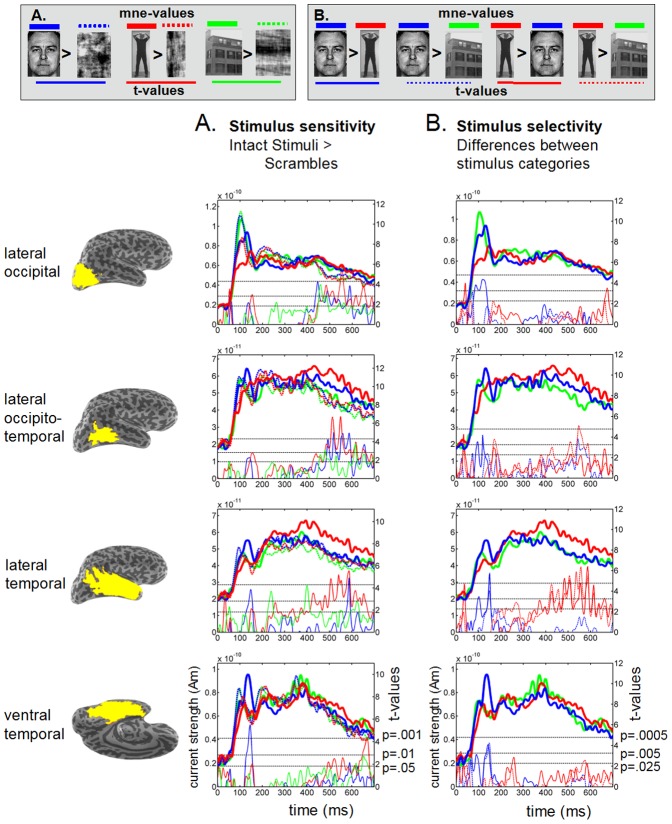
Time courses of MEG source estimates in anatomical regions of interest from the right hemisphere.Grand average (n = 10 subjects) time courses of the mean estimated current strength (thick lines) for intact (solid lines) Faces (blue), Bodies (red) and Houses (green) and their Fourier-scrambled versions (dashed lines), extracted from several large anatomical cortical regions. The thin line curves show the corresponding t-values for planned comparisons. The dotted black horizontal lines indicate the t-thresholds that correspond to α-values of 0.05, 0.01 and 0.001. A. Category sensitivity: The thin lines display the t-values for the contrasts between each intact stimulus category and its own scrambled counterpart (paired t-tests, one-sided, n = 10 subjects, df = 9) in blue (Faces>Scrambled Faces), red (Bodies>Scrambled Bodies) and green (Houses>Scrambled Houses). The dotted black horizontal lines indicate the t-thresholds that correspond to p-values of 0.05, 0.01 and 0.001. B. Category selectivity: The thin lines represent the t-values for the following contrasts: Faces>Bodies (blue solid line), Faces>Houses (blue dotted line), Bodies>Faces (red solid line) and Bodies>Houses (red dotted line). The contrasts were tested two-sided (n = 10, df = 9), but only one side is presented in the graph. Consequently, the p-values correspond to α/2. The dotted black horizontal lines indicate the t-thresholds that correspond to p-values of 0.025, 0.005 and 0.0005. Note that the vertical scales on the left axis for mne-values, and on the right axis for the t-values vary between graphs.